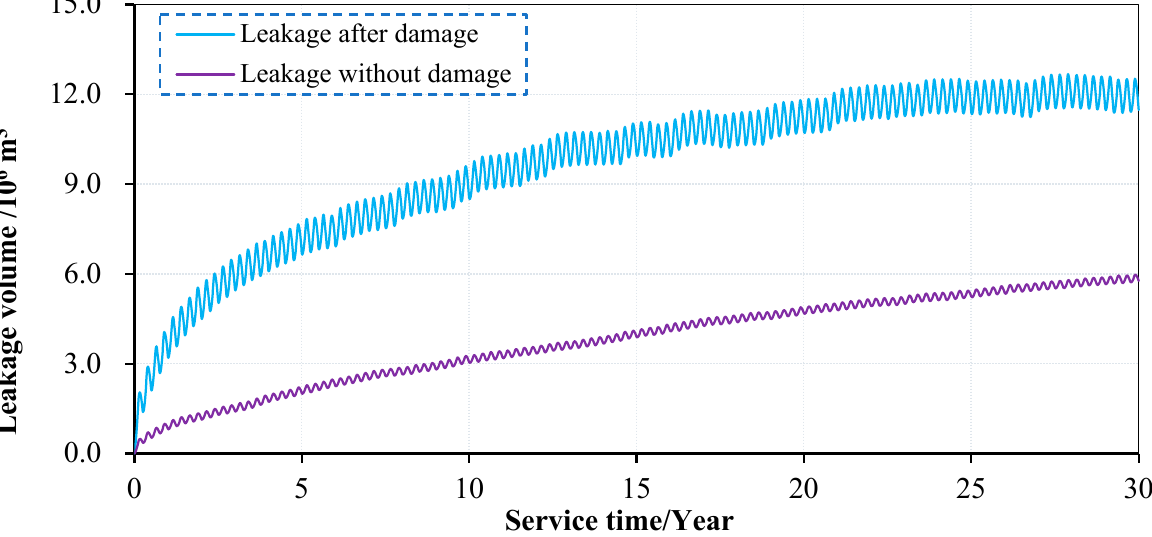
Figure 16. Comparison of cumulative leakage volume between the damaged and undamaged coal pillar dam.